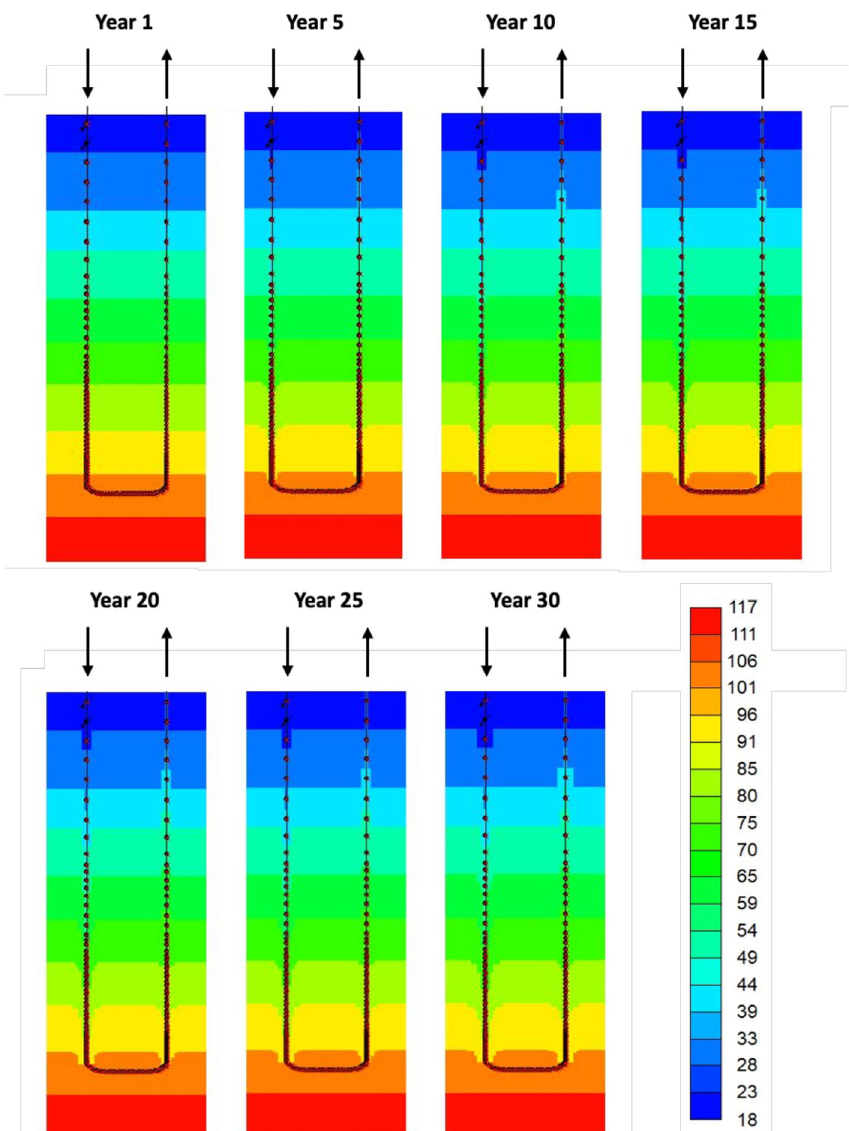
Fig. 6 Example of temperature distribution in the plane of the U-Tube well at flow rate of 400 m 3